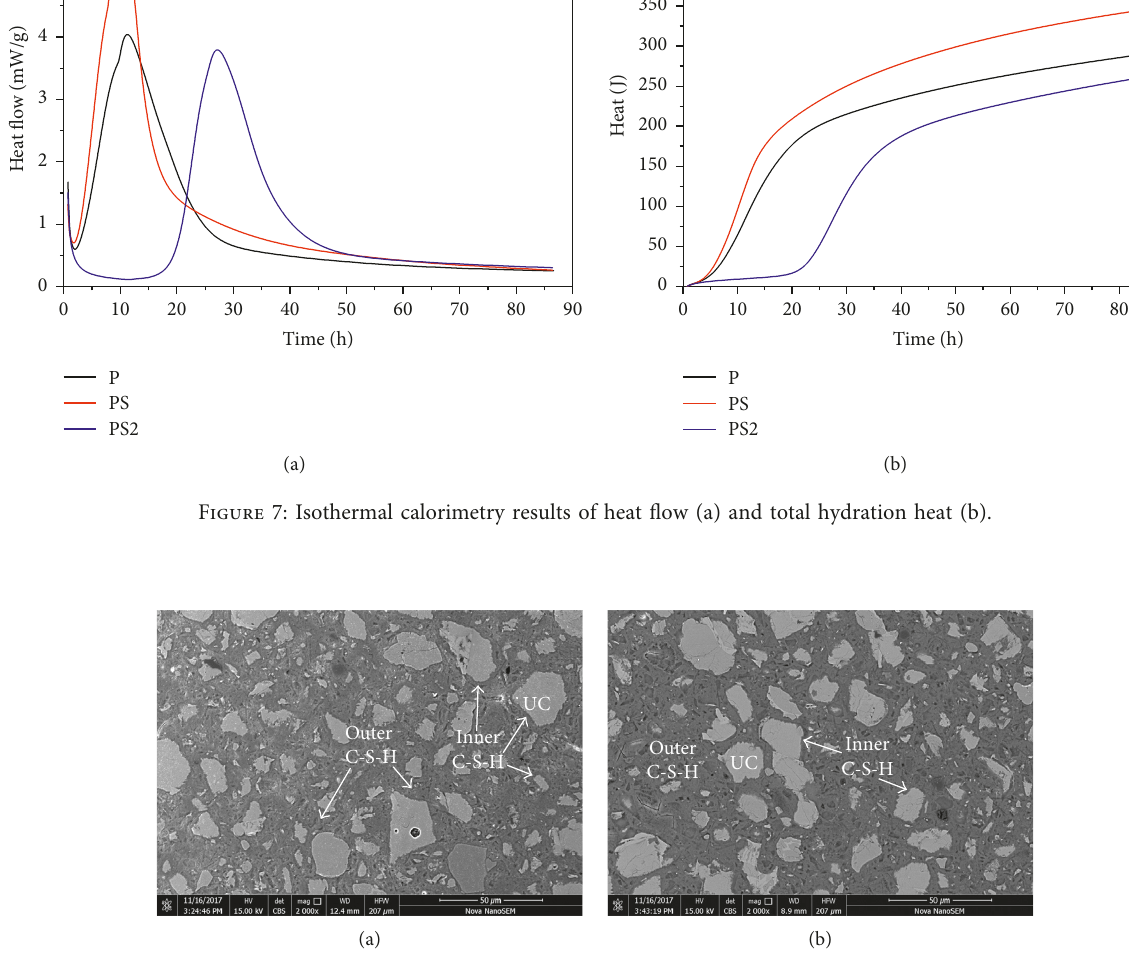
Figure 8: The BSE images of cement hydrated with (a) SF and (b) MSF.